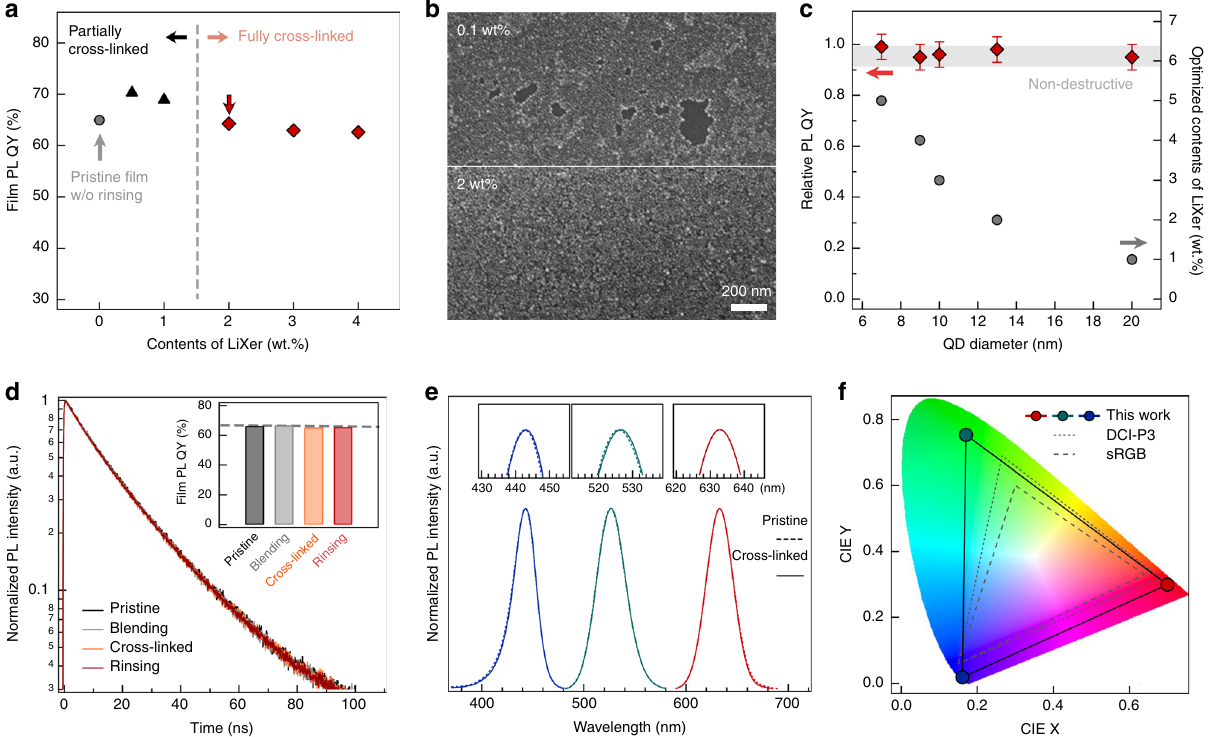
Fig. 4 Photophysical properties of crosslinked QD fi lms. a Film PL QYs of 13-nm sized red-emitting CdSe/CdZnS QD fi lms as a function of added LiXer contents. b SEM images of crosslinked 13-nm sized red CdSe/CdZnS QD fi lms with 0.1 wt% (top) and 2 wt% (bottom) LiXer after rinsing. c The optimum LiXer contents for different sized red-emitting QDs (grey circle) and relative PL QYs of crosslinked QD fi lms prepared with the optimum LiXer contents (red square) in comparison with pristine QD fi lms. Error bar represents the standard deviation of the data collected from >5 samples prepared independently. d PL decay curves of 13-nm sized red-emitting CdSe/CdZnS QD fi lms with 2 wt% of LiXer throughout the fi lm spin-casting (grey), crosslinking (orange) and rinsing (red) steps. PL decay curve of the pristine QD fi lm (black) is overlaid for comparison. Inset: fi lm PL QYs of each fi lms. Each decay curve was normalised to its maximum count value. e PL spectra of pristine (dashed line) and crosslinked (solid line) red-, green- and blue-QD fi lms. The PL QY for the pristine red-, green- and blue-QD fi lms is 65%, 64% and 80%, respectively. Each spectrum was normalised to its maximum PL intensity. Insets expand each spectrum at their peaks. f The colour coordinates of red-, green- and blue- QD fi lms in the 1931 CIE chromaticity diagram along with standard colour spaces (sRGB, >99.8%) were purchased from Sigma Aldrich. Myristic acid (MA, 90%), cadmium oxide (CdO, 99.9%) were purchased from Alfa Aesar. 4-Azido-2,3,5,6-tetra-